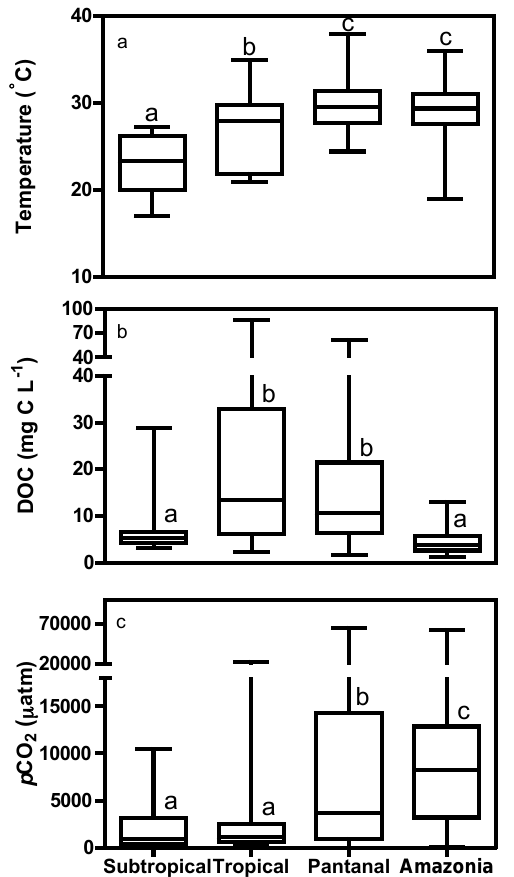
Figure 2. Values of (a) temperature ( ◦ C), (b) DOC concentra- tions (mgCL − 1 ) and (c) p CO 2 concentration (µatm) of Brazil- ian lakes sampled from different biomes, as defined by subtropi- cal coastal lakes ( n = 37), tropical coastal lake ( n = 63), Pantanal floodplain ( n = 58) and Amazonia forest ( n = 67). The line depicts the median. The boxes show the quartiles, and the whiskers mark the 10th and 90th percentiles. Different lowercase letters near the box plot indicate significant statistic differences between the groups (Kruskall–Wallis followed by Dunn’s multiple comparison post hoc test, p <0.05).